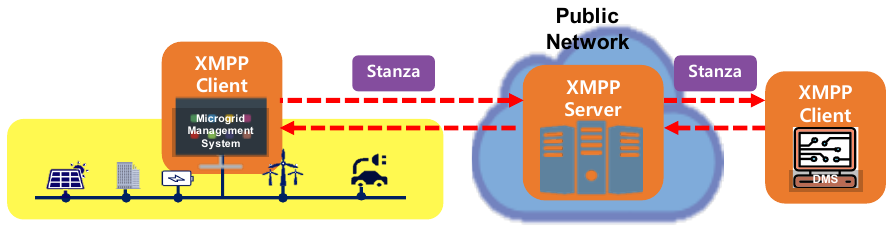
Figure 4. XMPP-based communication